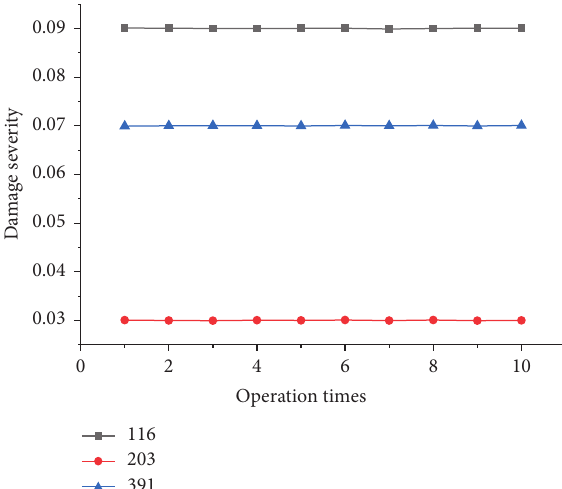
Figure 16: Damage severity identification of 0.8PSO.